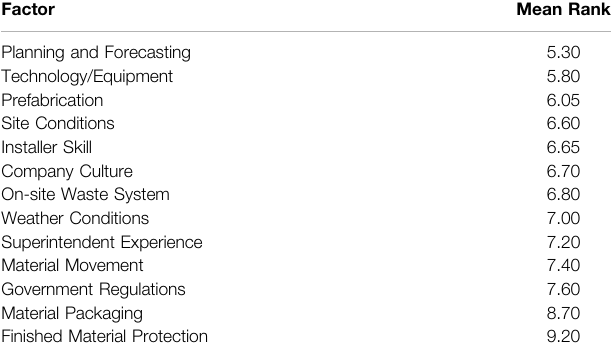
TABLE 9 | Mean ranks of the factors: responses of the participants with a bachelor ’ s or a master ’ s